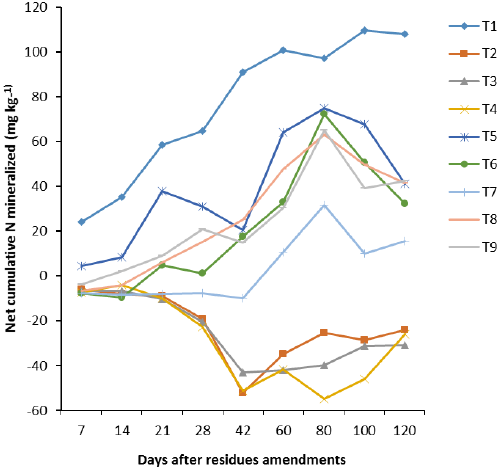
Figure 1. Net cumulative N mineralized from the added plant residues at different incubation periods. Legend: T 1 is Glycine max shoot, T 2 is Glycine max root; T 3 is Zea mays shoot, T 4 is Zea mays root; T 5 is Trifolium repens shoot; T 6 is Trifolium repens root; T 7 are Populus euramericana leaves; T 8 are Robinia pseudoacacia leaves; T 9 are Elaeagnus umbellata